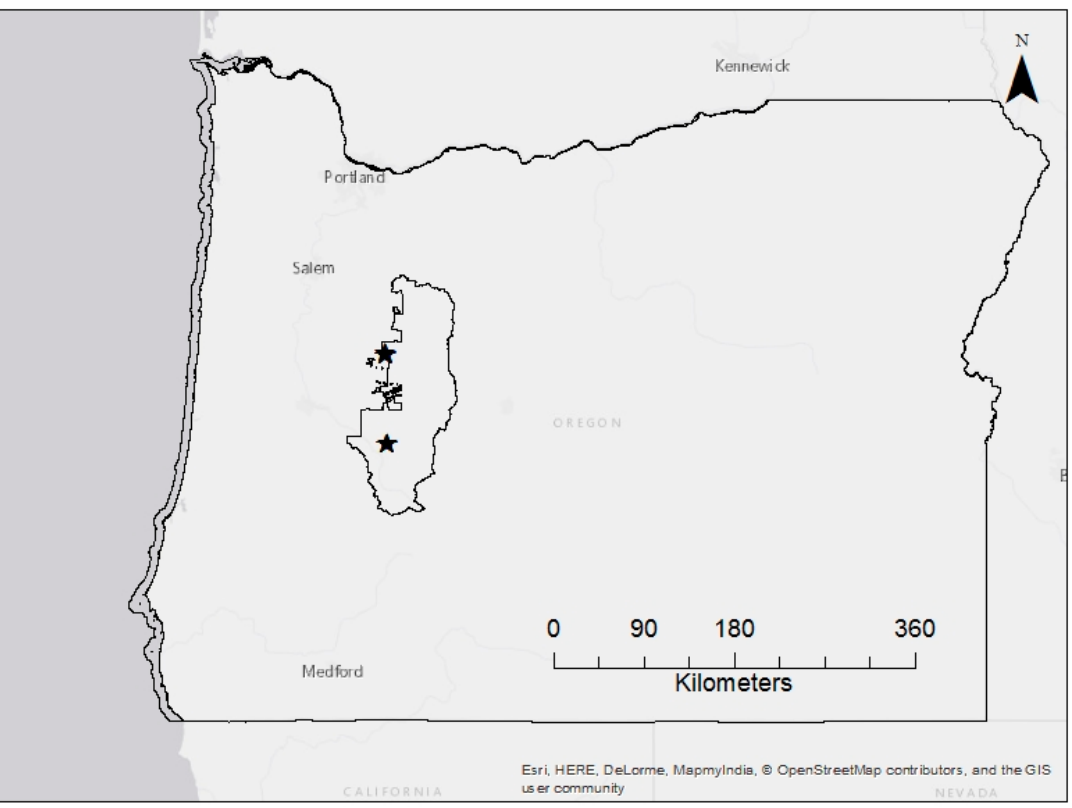
Figure 1. Map of the study area. Location of stands from which sample trees were selected are indicated by stars.